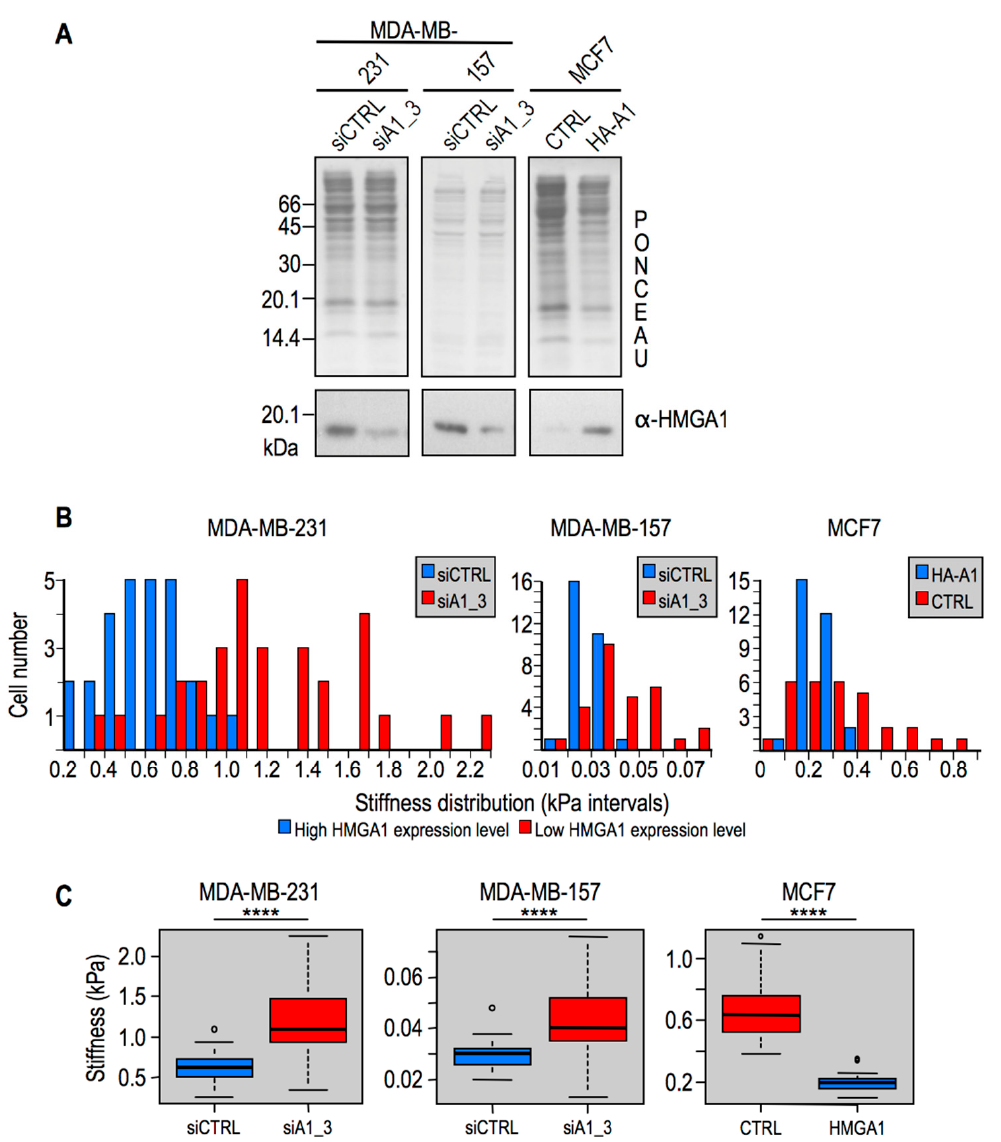
Figure 2. Cellular stiffness is modulated by changes in HMGA1 (High Mobility Group A 1) expression levels. In MDA-MB-231 and MDA-MB-157 cells HMGA1 expression has been silenced by siRNA, whereas in MCF7 cells HMGA1 has been overexpressed by means of transfection with a HA-HMGA1 protein expression vector. CTRLs indicate control experiments performed with siCTRL or an empty HA-expression vector. ( A ) Western blot analyses to assess HMGA1 protein expression levels in the three cellular models. Red ponceau membranes are shown as controls for protein loading normalization. Molecular weight markers are indicated on the left (kDa). ( B ) Stiffness distributions of all cell populations analyzed. ( C ) Box plots illustrative of median and quantile distribution of the three different cell population analyzed (****: p < 0.0001).